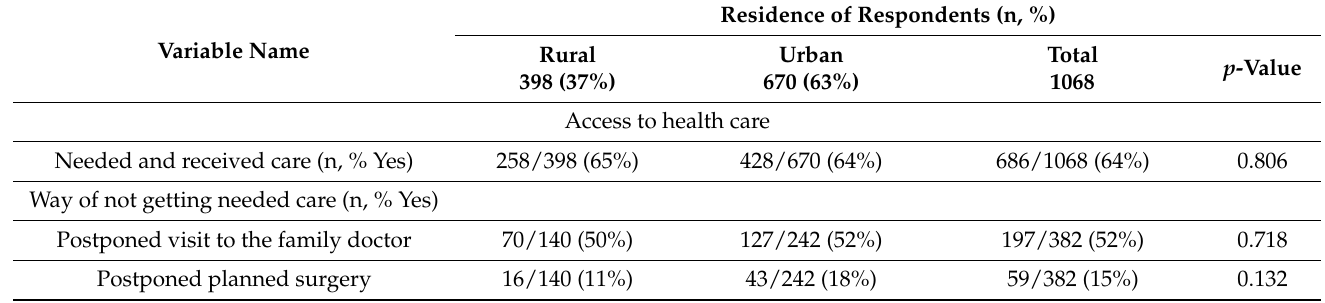
Table 2. Self-perceived access to care, postponements of care, and mental health in the adult population of Bosnia and Herzegovina during the COVID-19 pandemic by residence of respondents